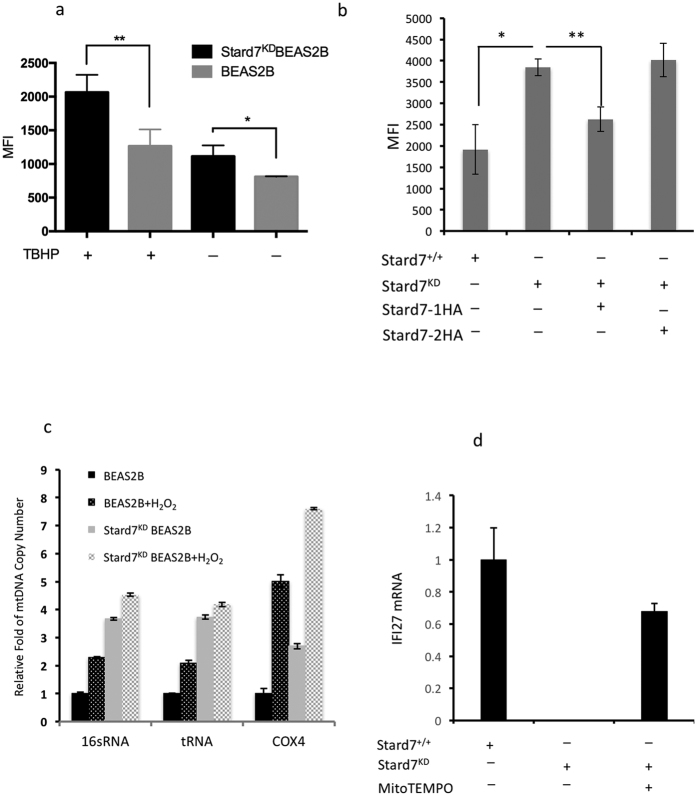
Stard7 deficiency leads to excessive generation of ROS and mitochondrial DNA damage.(a) BEAS-2B and Stard7KDBEAS-2B cells were incubated with or without DCFDA (20 μM) and/or TBHP (25 μM) to induce oxidant stress and cultured for 3 hours. ROS were analyzed by flow cytometry. Data are expressed as MFI (mean ± SEM, n = 3); *p = 0.032, BEAS-2B cells vs. Stard7KDBEAS-2B cells; **p = 0.0186, TBHP-treated BEAS-2B cells vs. TBHP-treated Stard7KDBEAS-2B cells. (b) Knockdown cells were transiently transfected with Stard7-1HA or Stard7-2HA and ROS levels assessed as described in panel a. *p = 0.0111, Stard7KDBEAS-2B cells vs. BEAS-2B cells; **p = 0.0072, Stard7-1HA transfected Stard7KDBEAS-2B cells vs. Stard7KDBEAS-2B cells. (c) Relative mitochondrial DNA copy numbers were determined by qRT-PCR using primers for mitochondrial genes (16 sRNA, tRNA and Cox4) or a nuclear gene (actin). (d) Expression of the oxidant–sensitive gene interferon alpha inducible protein 27 (IFI27) was assessed in BEAS-2B and Stard7KDBEAS-2B cells by qRT-PCR before and after treatment with MitoTEMPO. MFI: mean fluorescent intensity. DCFDA: dichlorofluorescin diacetate; TBHP: tert-butyl Hydroperoxide.